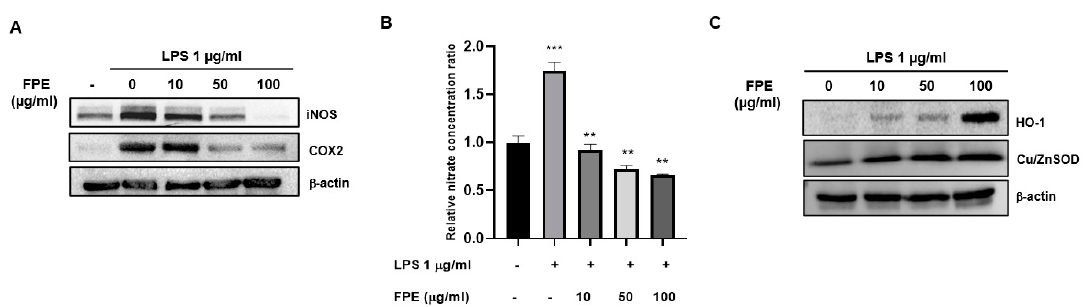
Figure 5. The anti-inflammatory activity of FPE in Raw264.7 murine macrophages was found to increase in a dose-dependent manner. ( A ) Western blotting showed a dose-dependent effect on the expression levels of iNOS and COX2 proteins following co-treatment of cells with 1 μ g/mL LPS and 10, 50, and 100 μ g/mL FPE for 24 h. ( B ) The adjacent bar graphs demonstrate the dose-dependent capacity of FPE to lower nitrate levels in Raw264.7 murine macrophages, following co-treatment with 1 μ g/mL LPS and 10, 50, and 100 μ g/mL FPE. Results are shown as mean ± SEM; n = 3, ** p < 0.01, *** p < 0.0001. ( C ) Western blotting of HO-1 and Cu/ZnSOD protein expression. The result shows expression levels of both proteins when cells were treated with 10, 50, and 100 μ g/mL FPE for 24 h in a dose-dependent manner.